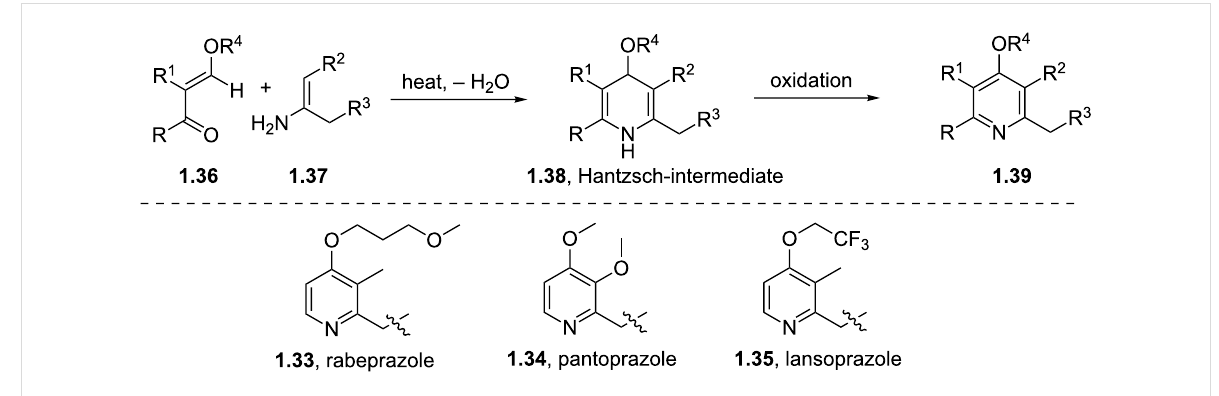
Scheme 7: Hantzsch-like route towards the pyridine rings in common proton pump